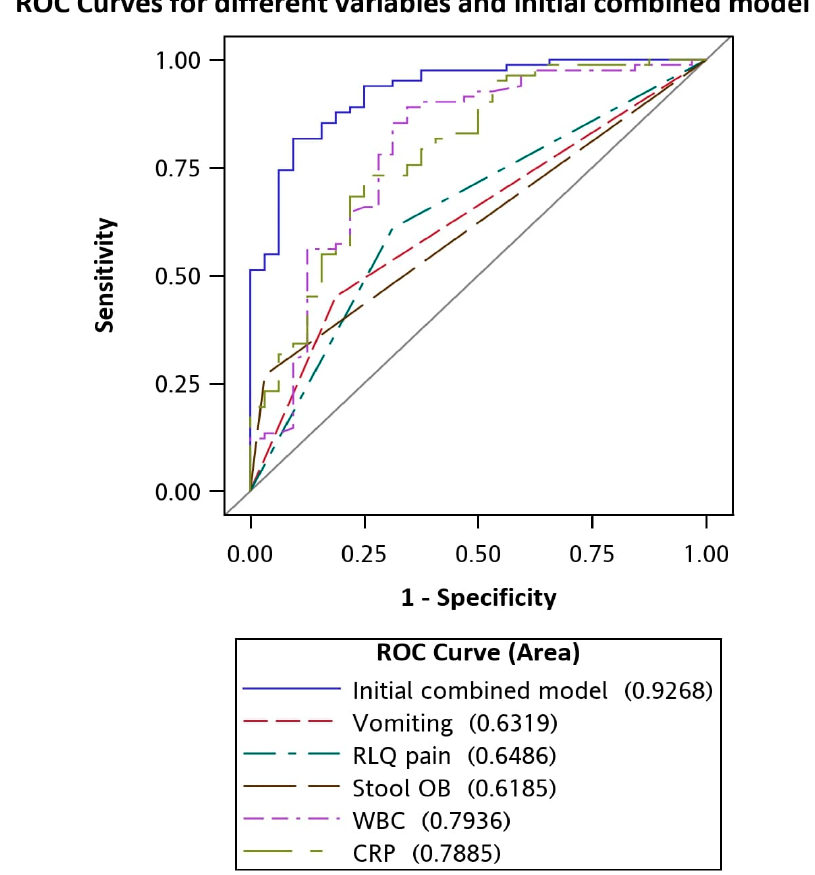
Figure 2. ROC curves for vomiting, RLQ pain, negative stool OB, CRP level, WBC level, and the initial combined model for differentiating between appendicitis and gastroenteritis.